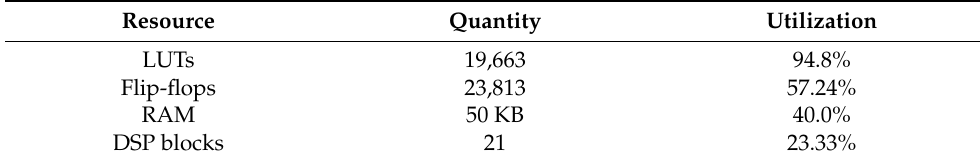
Table 1. FPGA resource